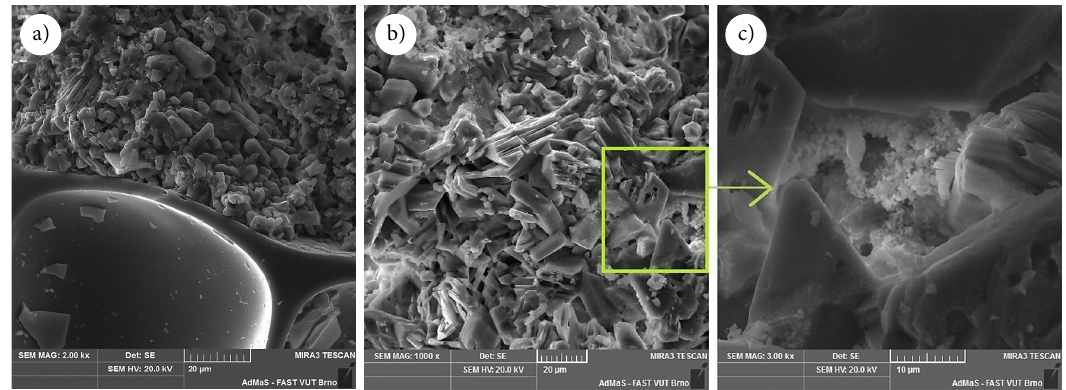
Figure 2. The microstructure of the composition with expanded perlite: (a) – in the contact zone without plasticizer, (b) – with the DC-5 plasticizer, (c) – microstructure fragment with inclusion of